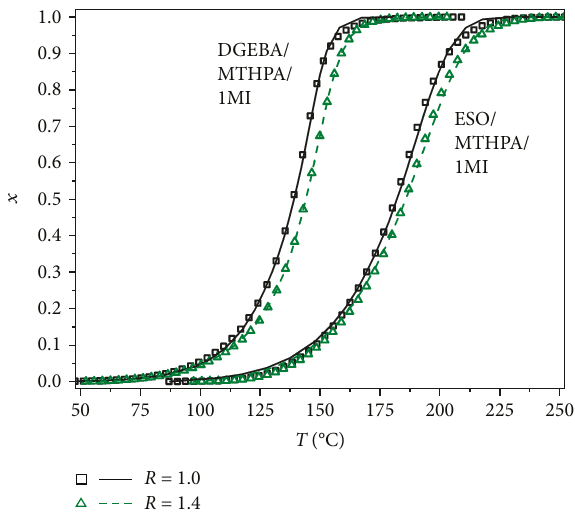
Figure 4: x - T curves for the curing of DGEBA and ESO with MTHPA and 1MI, with stoichiometric ratios R = 1 0 and R = 1 4 , corresponding to q = 10 ° C/min . Solid lines show the obtained fi ttings to equations (3) and (4).